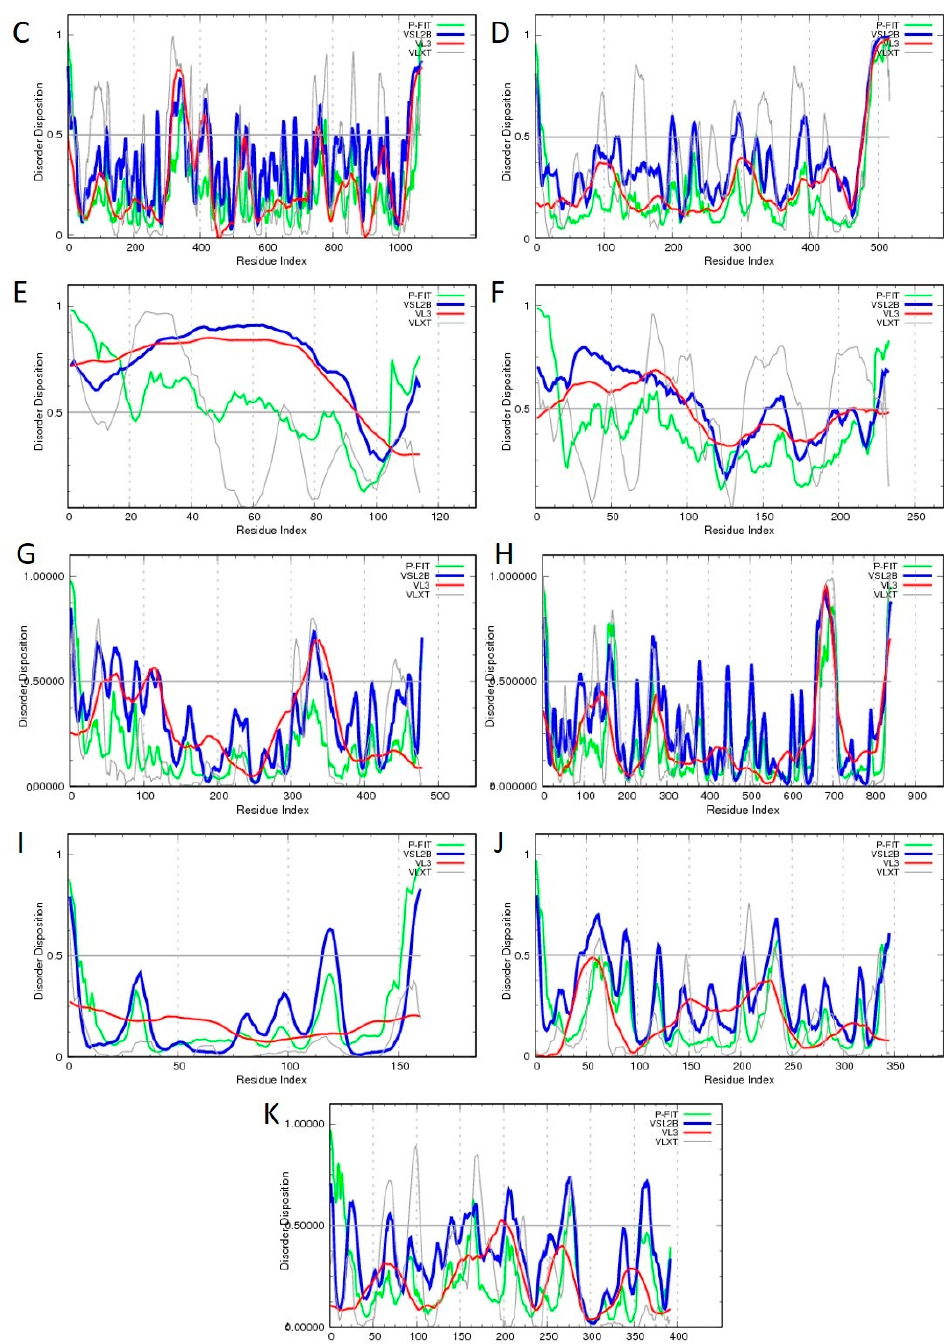
Figure 4. Intrinsic disorder status of the protomers of the V-ATPase from Saccharomyces cerevisiae evaluated by PONDR-FIT (green curves), PONDR ® VLXT (gray curves), PONDR ® VSL2 (blue curves), and PONDR ® VL3 (red curves) [106–111]. ( A ). V-type proton ATPase subunit D (UniProt ID: P32610, predicted disorder content (PDC) 47.3%); ( B ). V-type proton ATPase subunit F (UniProt ID: P39111, PDC = 22.9%); ( C ). V-type proton ATPase catalytic subunit A (UniProt ID: P17255, PDC = 20.6%); ( D ). V-type proton ATPase subunit B (UniProt ID: P16140, PDC = 17.9%); ( E ). V-type proton ATPase subunit G (UniProt ID: P48836, PDC = 67.3%); ( F ). V-type proton ATPase subunit E (UniProt ID: P22203, PDC = 50.8%); ( G ). V-type proton ATPase subunit H (UniProt ID: P41807, PDC = 17.0%); ( H ). V-type proton ATPase subunit a, vacuolar isoform (UniProt ID: P32563, PDC = 12.5%); ( I ). V-type proton ATPase subunit c (UniProt ID: P25515, PDC = 3.1%); ( J ). V-type proton ATPase subunit d (UniProt ID: P32366, PDC = 12.3%); ( K ). V-type proton ATPase subunit C (UniProt ID: P31412, PDC =